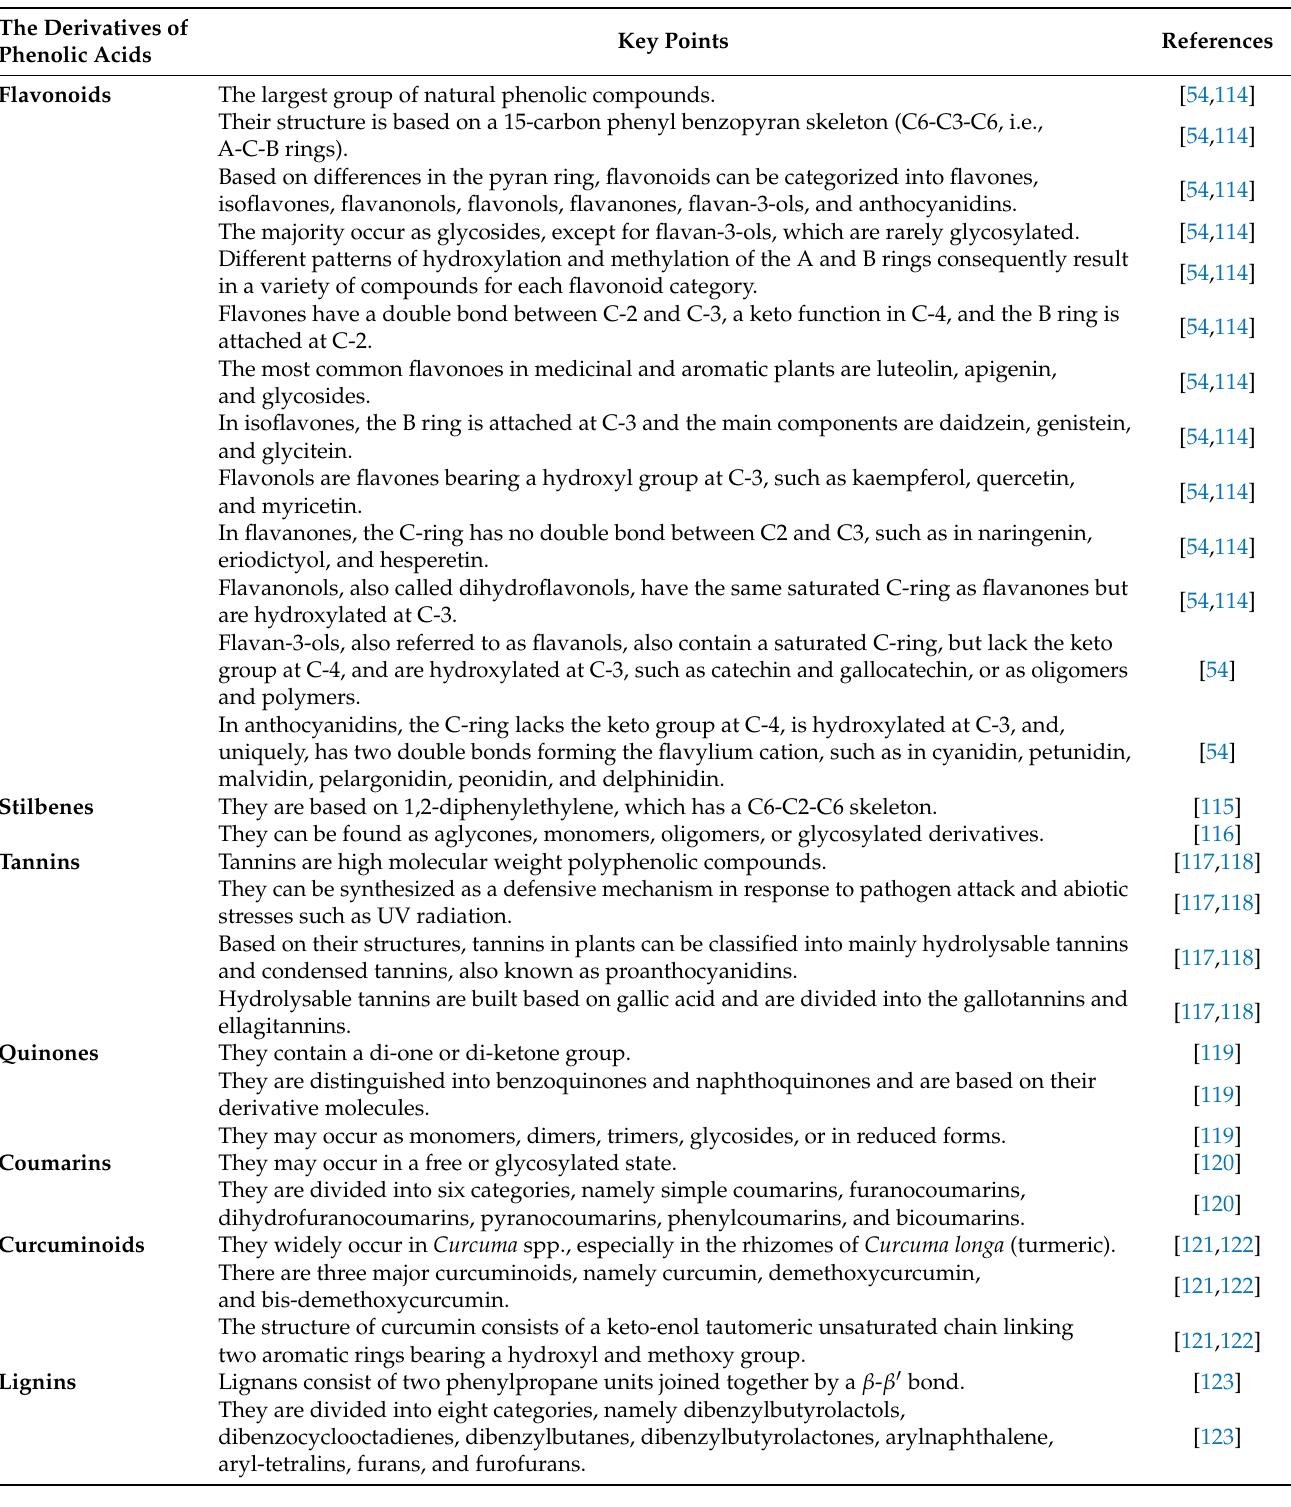
Table 4. Important points about phenolic acids and their